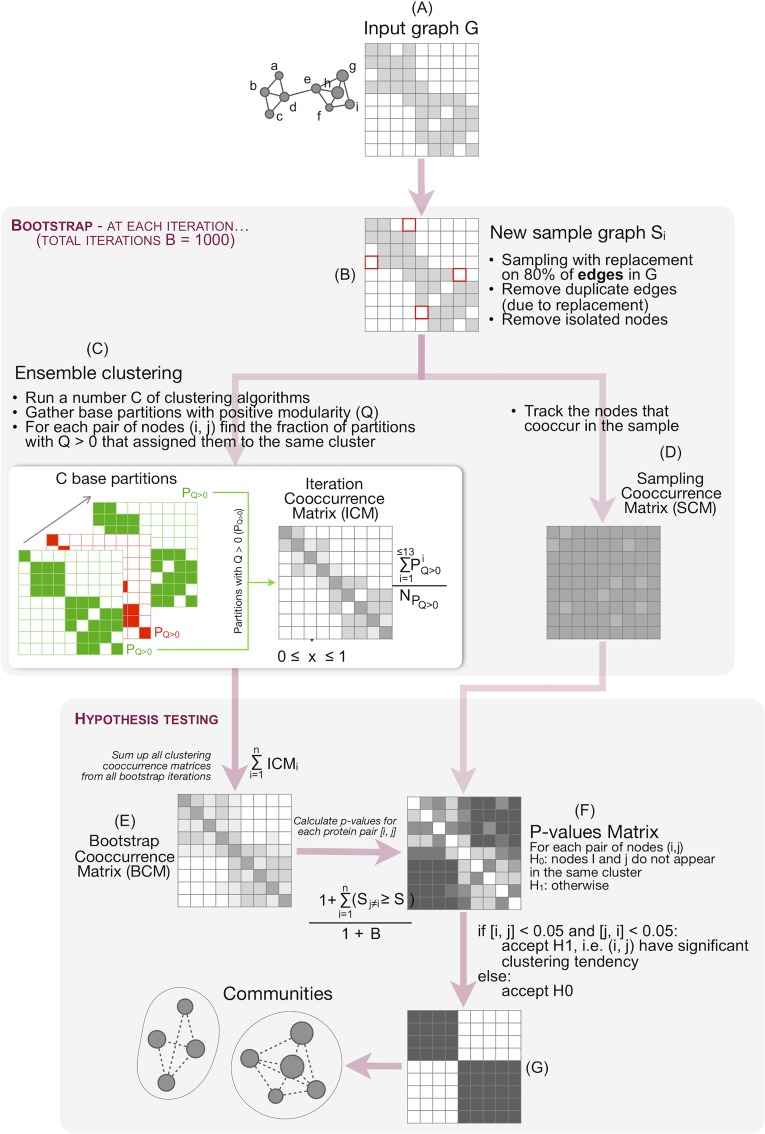
Consensus clustering protocol.(A) Starting from an input network, a series of bootstrap sample graphs are generated. (B) Each sample graph is generated taking 80% of the edges of the input graph G. (C) At each bootstrap iteration, 13 clustering algorithms are applied to the sample graph Gi. From the resulting partitions, those with positive modularity are integrated into a consensus partition for that iteration (ICM). (D) Throughout the bootstrap procedure, the number of times that two nodes appear in the same sample graph is tracked (SCM) to use later when computing p-values. (E) All ICMs are integrated into a BCM. (F) p-values are calculated as indicated in Eq 3, using matrices ICM and BCM. (G) Cells with statistically significant values are used to define the final clusters in the network. BCM, bootstrap co-occurrence matrix; ICM, Iteration co-occurrence matrix; SCM, sampling co-occurrence matrix.